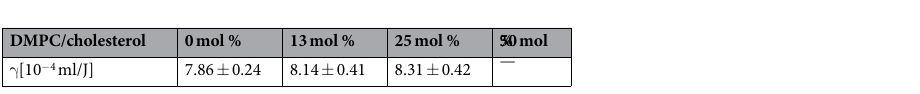
Figure 2 represents the raw data of the elastic neutron intensities (corrected only for the incoming neutron flux) for pure DMPC (reproduced from ref. 31 ) and the DMPC/cholesterol mix- tures at 25 and 50 mol% cholesterol summed over all accessible scattering angles (corresponding to a range of 0.29 Å − 1 < Q < 4.98 Å − 1 ). In contrast to the MSD, where the Gaussian approximation 32,33 has to be fulfilled, the integrated intensities are not restricted to the Q-region below 1.47 Å − 1 . The mixture with 13 mol% cholesterol was